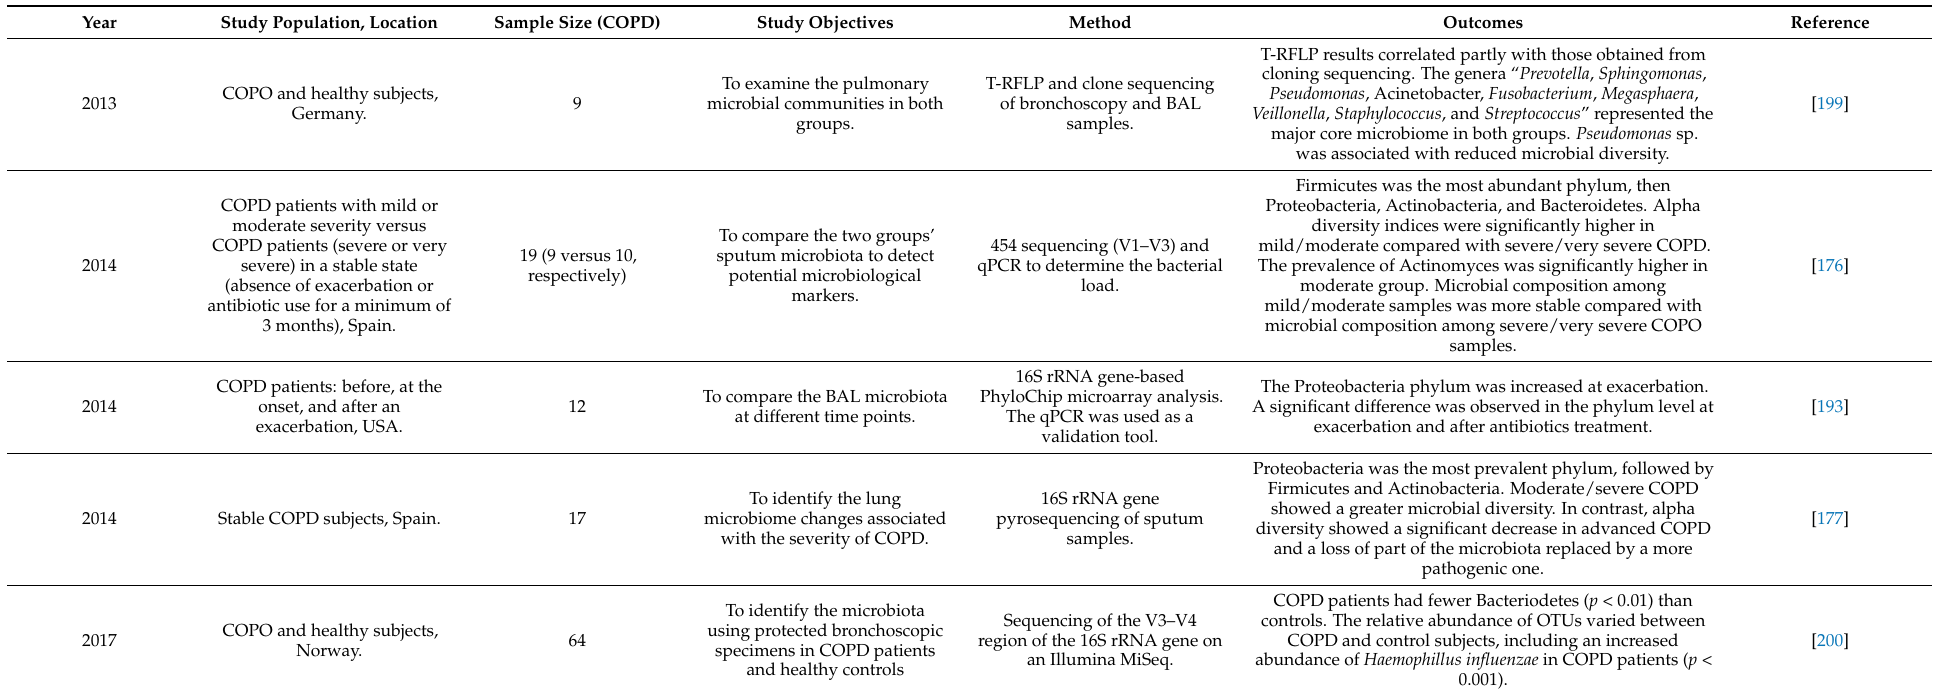
Table 4. Summary of the published studies related to the respiratory microbiome in COPD